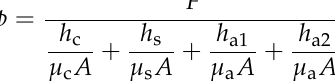
Figure 2. The schematic of MFL probe for steel pipe. ( a ) The probe with the non-ferromagnetic support (NFMS); ( b ) The probe with the ferromagnetic support (FMS).